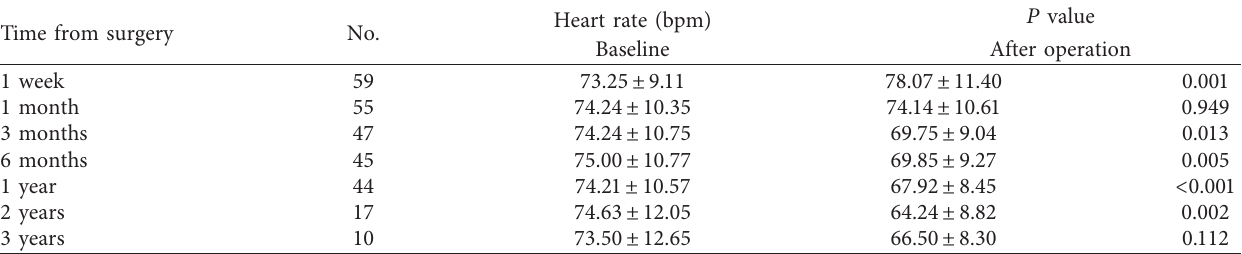
Table 2: Comparison of heart rates at baseline and postoperatively in liver cirrhosis patients. Time from surgery